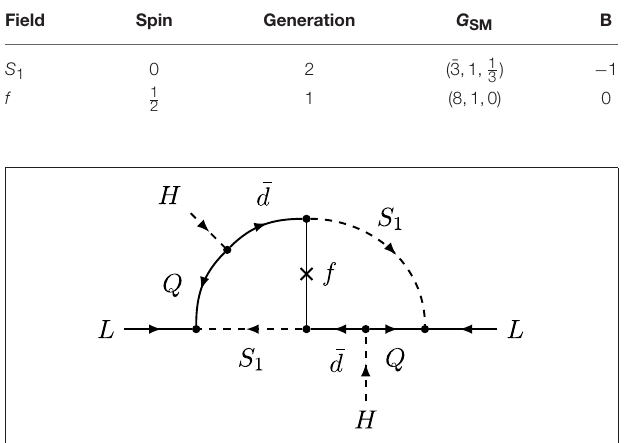
TABLE 11 | Quantum numbers of new particles in the Angelic model.